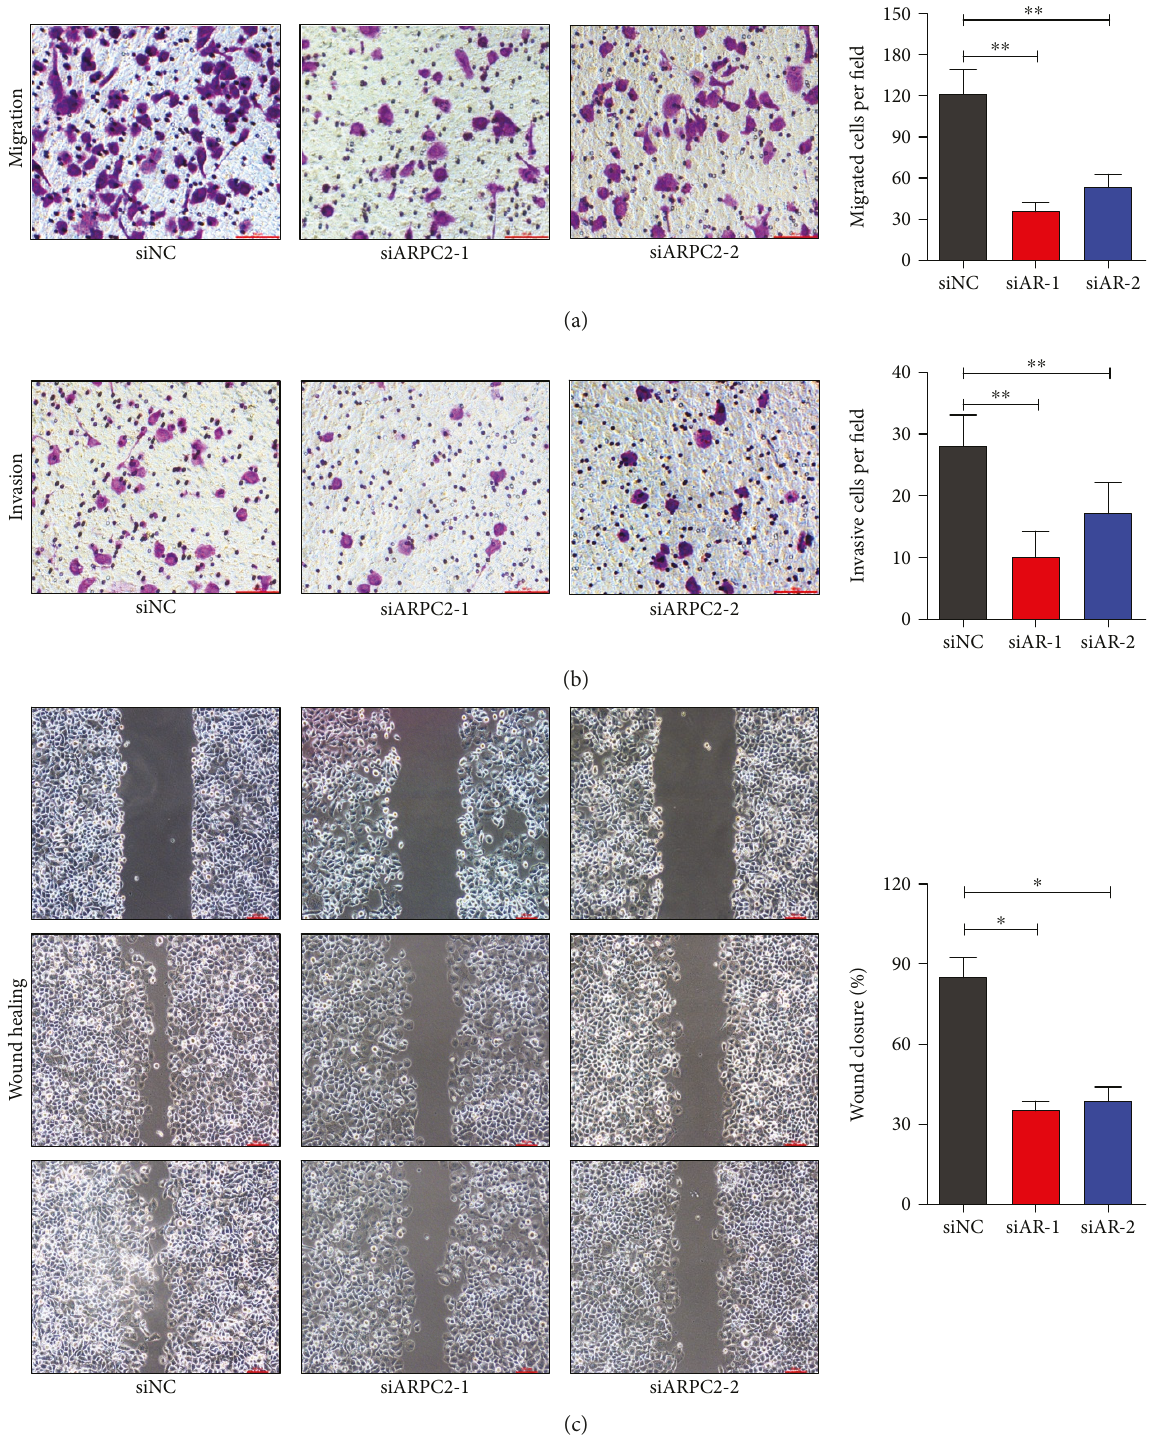
Figure 2: ARPC2 promoted invasion of AGS cells. MKN-28 cells were transfected with ARPC2-siRNA-1, ARPC2-siRNA-2, or negative control. (a) Migration assay; (b) invasion assay; and (c) wound healing assay were performed in MKN-28 cells after transfection. ∗ P < 0 05 . ∗∗ P < 0 01